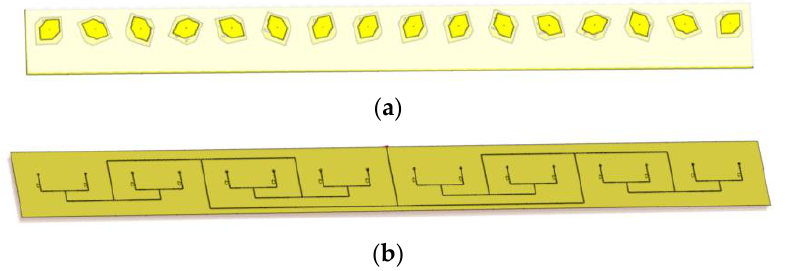
Figure 13. Design 2–16-element patch array. ( a ) Top view. ( b ) Bottom view. Figure 13. Design 2 – 16-element patch array. ( a ) Top view. ( b ) Bottom view.